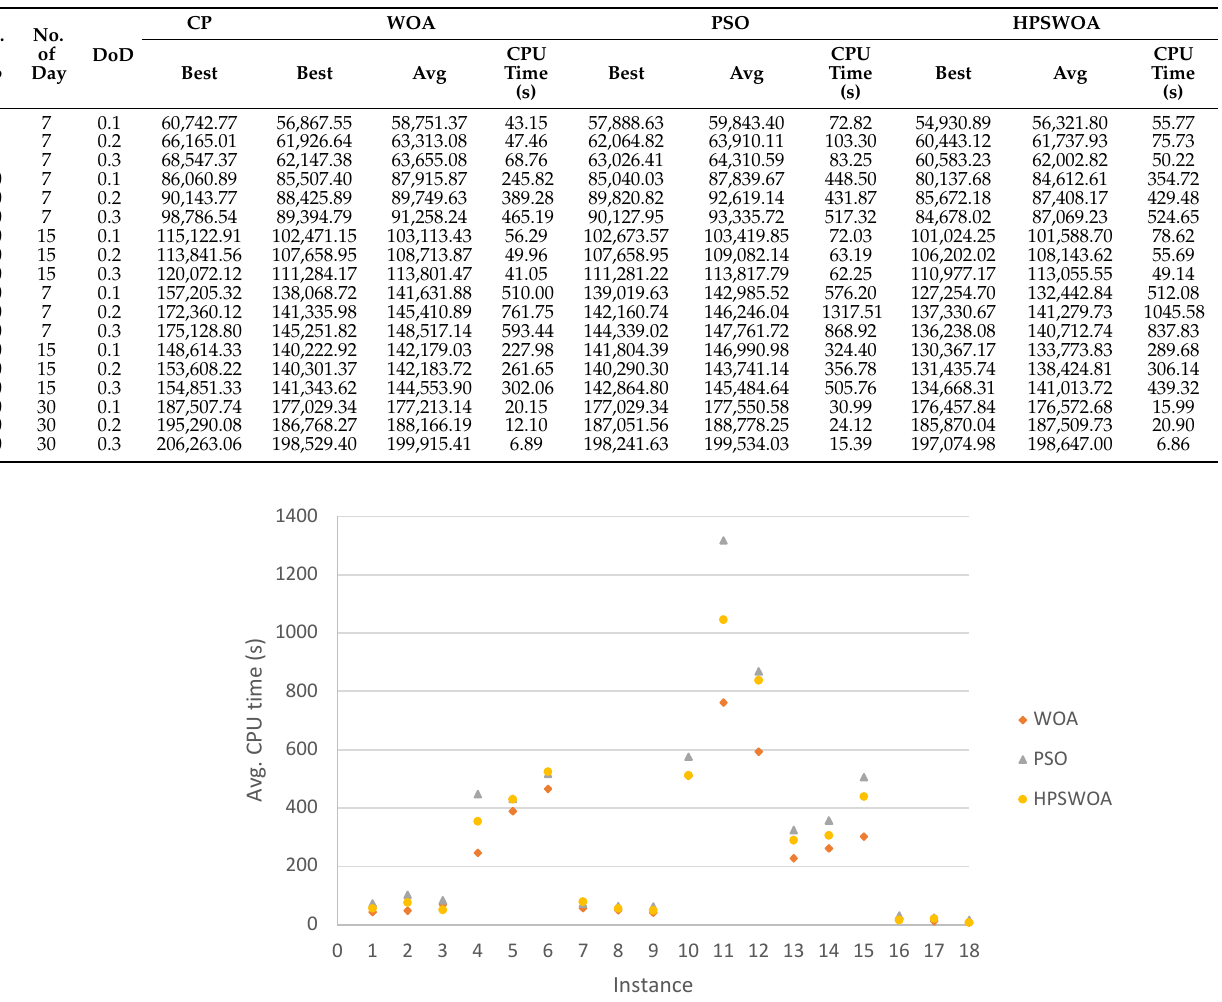
Table 7. Statistical test results for the average computational time obtained from Table 6. Table 6. The dynamic problem results for CP, the WOA, PSO, and the HPSWOA.